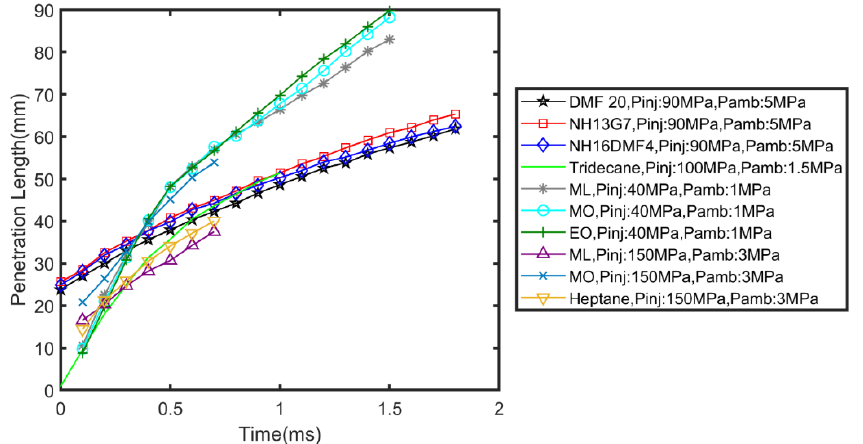
Figure 14. PL for various esters, aliphatic and aromatic additives with diesel at various injection & ambient pressure conditions [99,106,108,112].